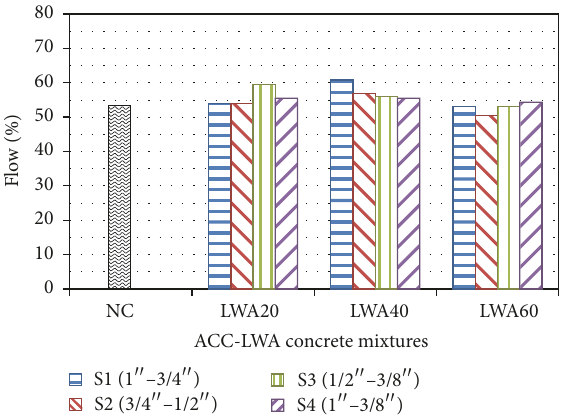
Figure 8: Slump values of NC and LWA mixtures. Figure 9: Flow values of NC and LWA concrete